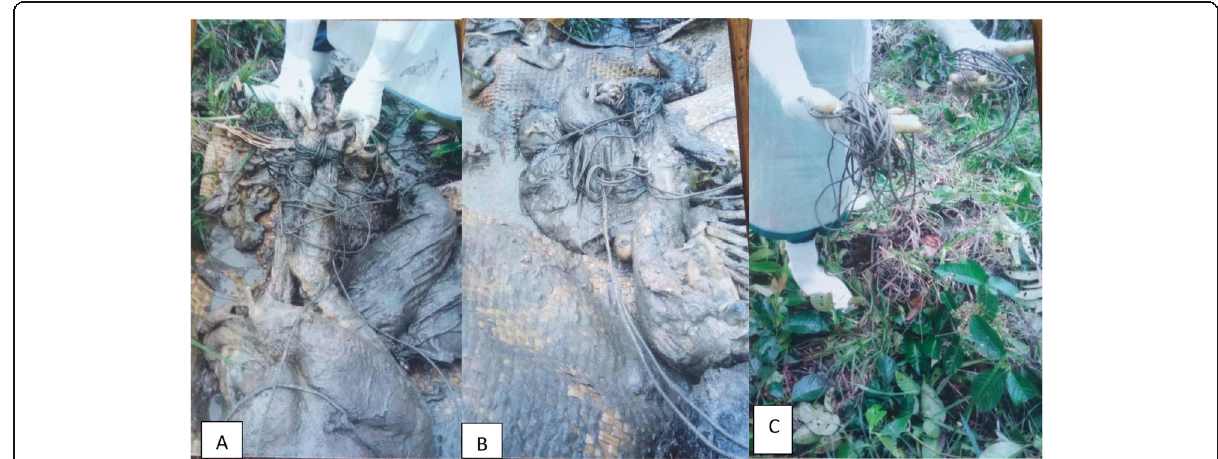
Fig. 7 a Legs and ankle tied up severally. b Thigh tied up. c Full length of rope